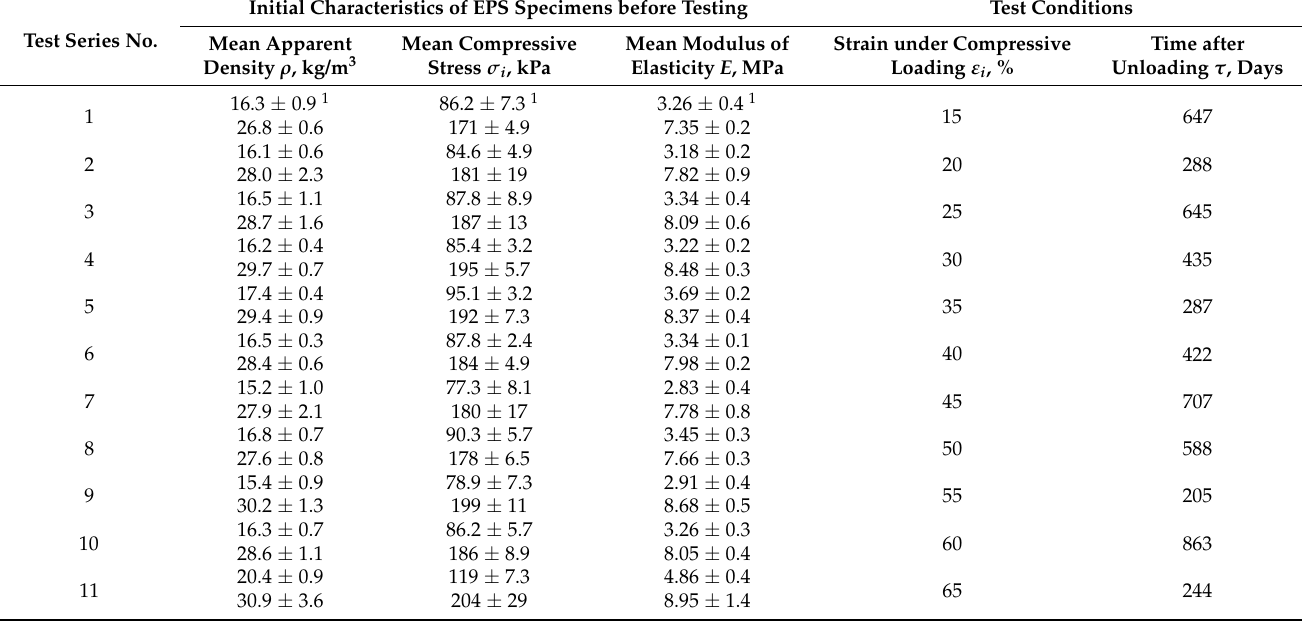
Table 1. Initial characteristics of EPS specimens for active and passive deformation after the short- term compression test and experimental values of residual (plastic)